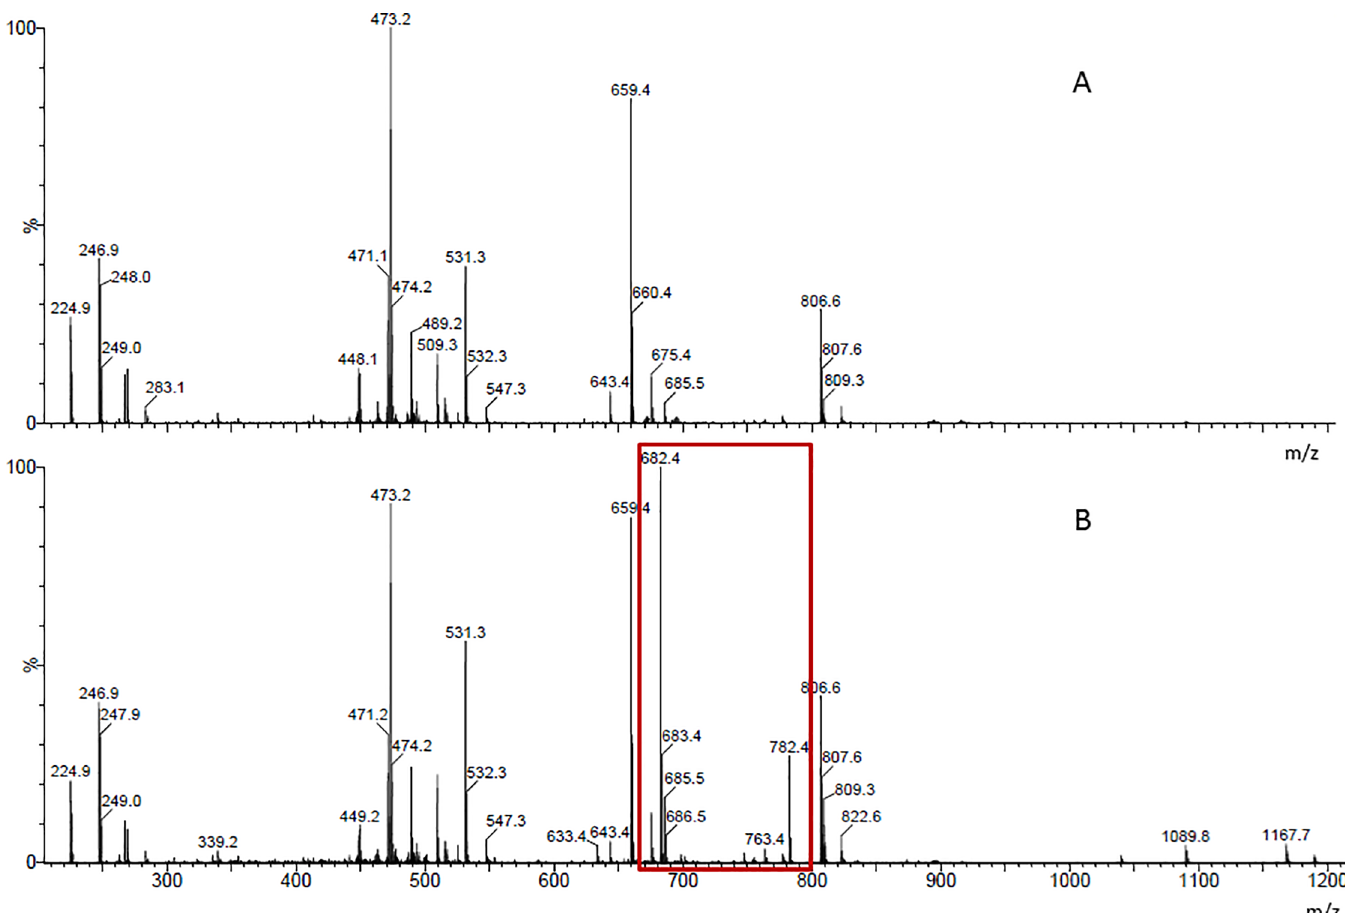
Fig 2. MALDI-TOF spectra of the reaction medium containing Impranil and the enzymatic extract of clone 44I12 at the beginning (A) and after 24h (B) of reaction. The red rectangle shows the new peaks observed after reaction.